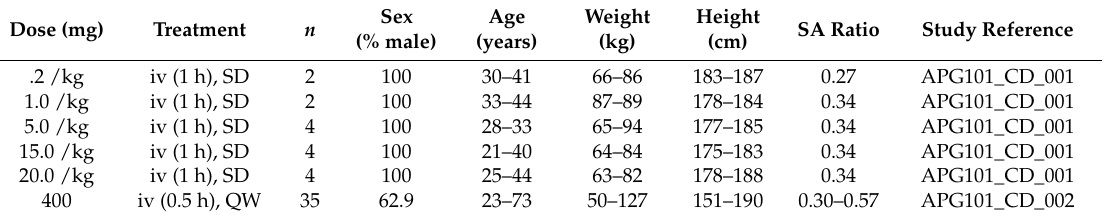
Table 1. Dosing groups used for asunercept model development and